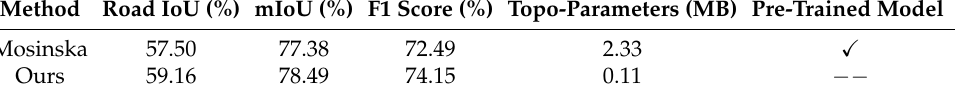
Table 3. Performance comparisons of Mosinska‘s method on the Massachusetts Dataset in terms of Road IoU, mIoU, F1 score, and topo-parameters, as well as whether a pre-trained model is needed. The best results are shown in